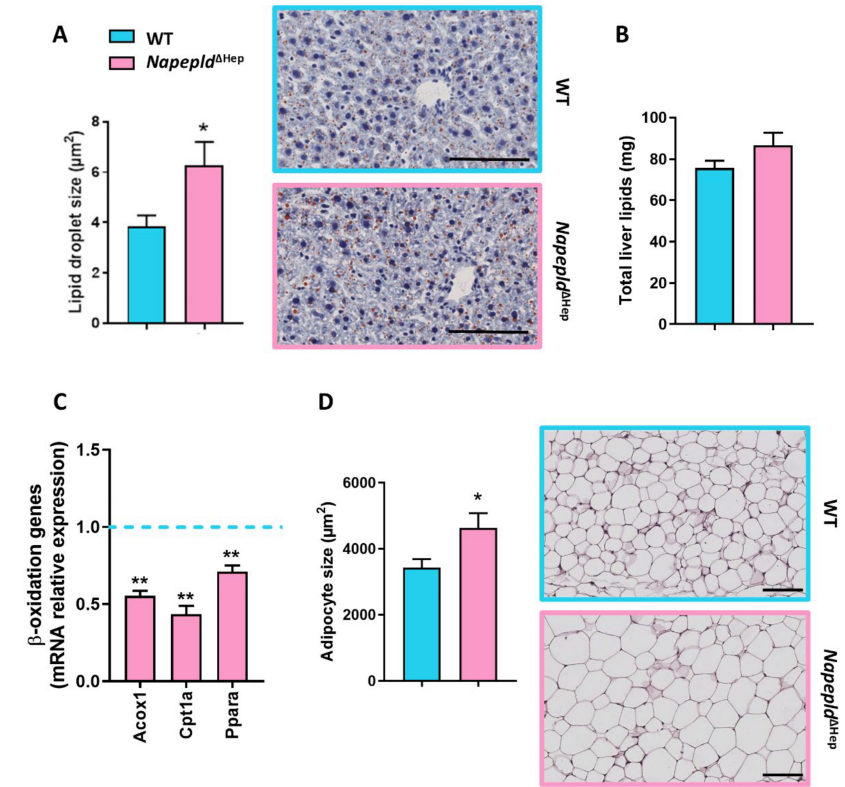
Figure 3. Napepld ∆ Hep mice are more sensitive to liver lipid accumulation. ( A ) Representative liver oil red O staining (scale bar: 100 µ m) and average lipid droplet size ( µ m 2 ). ( B ) Liver lipid content measured by gravimetry (mg). ( C ) mRNA expression of genes involved in β -ox idation measured by real-time qPCR in the liver. ( D ) Representative hematoxylin and eosin-stained pictures of SAT deposits (scale bar: 100 µ m) and mean adipocyte size ( µ m 2 ). Blue: WT ND mice. Pink: Napepld ∆ Hep ND mice ( n = 8–10). Data are presented as the mean ± s.e.m. *and ** indicate a significant di ff erence versus WT ND (Respectively p < 0.05 and p < 0.01) according to the t